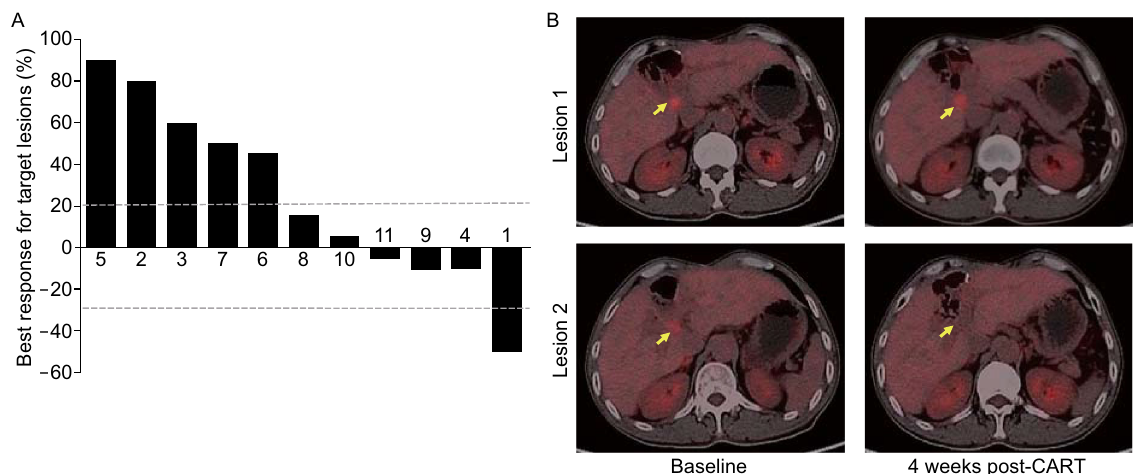
Figure 3. Clinical response. (A) Best overall response from baseline in the sum of the longest diameters of target lesions as assessed per RECIST 1.1 in patients who had at least one post-baseline tumor assessment. (B) Patient No. 1, a 62-year-old male with poorly differentiated perihilar CCA accompanied by Her2 protein overexpressed in >90% tumor cells, whose PET-CT showed 2 metastatic lesions in his hepatic hilum (yellow arrows) obtained a PR 4 weeks after one cycle of CART-HER2 therapy, assessed by PET-CT showing the disappearance of lesion 2.